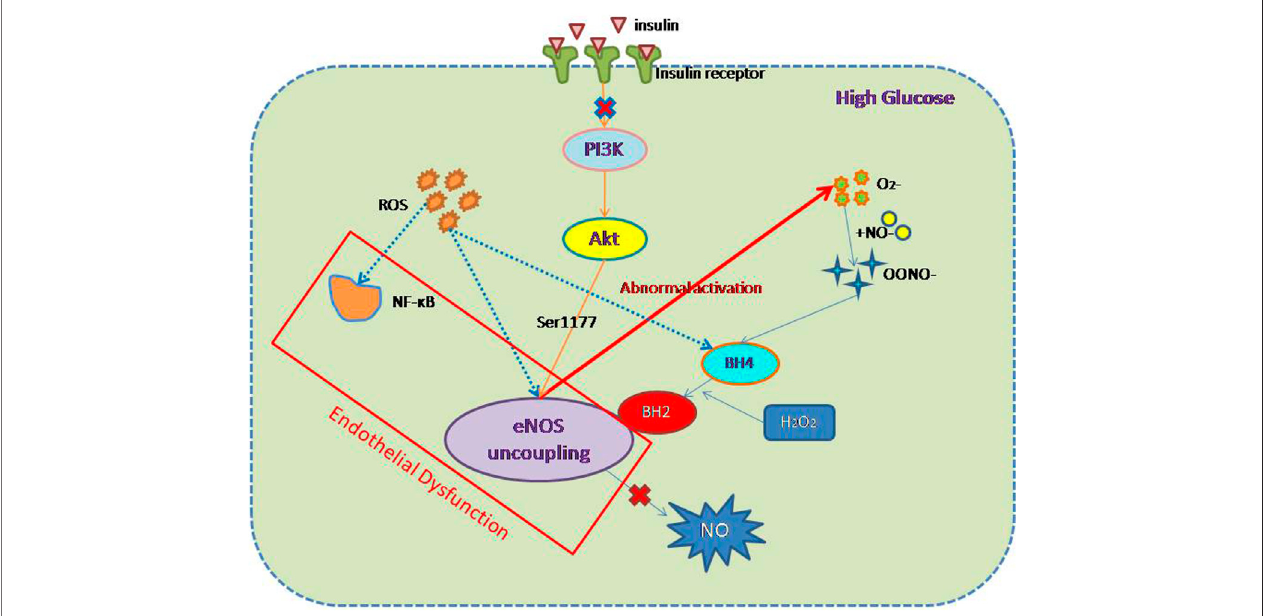
FIGURE1| Mechanismofendothelialdysfunctionassociatedwithdiabetes.InDM,cellsexistinahigh-glucoseenvironment,buttheetiologyofEDassociatedwith DM can be divided into two components: fi rst, oxidative stress and in fl ammation; and second the uncoupling of eNOS and a reduction in NO production. The main mediatorsofoxidativestressandin fl ammationareROSandNF- κ B.ThemechanismofeNOSdecouplinginvolves(1)abnormalactivationofeNOS,leadingtoareduction inNOproduction;(2)inhibitionofthePI3K/AKT/eNOSpathwayasacomponentofinsulinresistance;and(3)ROSactivation,leadingtoareductioninnormaleNOS activation and an increase in the concentration of inhibitory